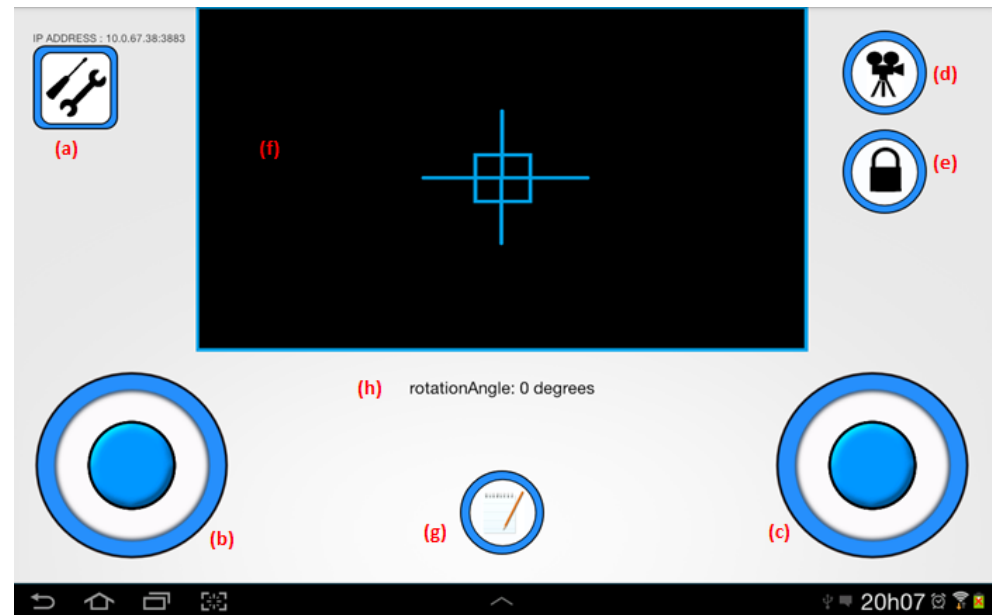
Figure 12. Mobile application interface.